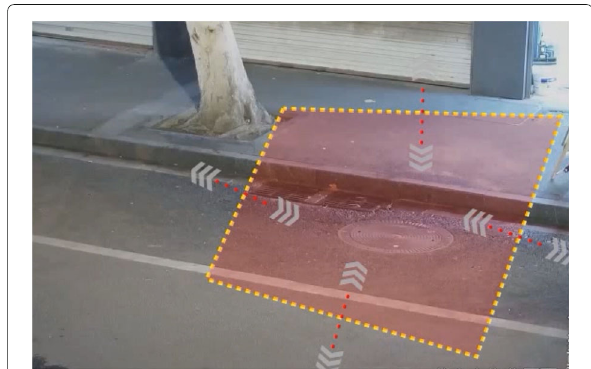
Fig. 8 Illustration of the “Region Of Interest” operator